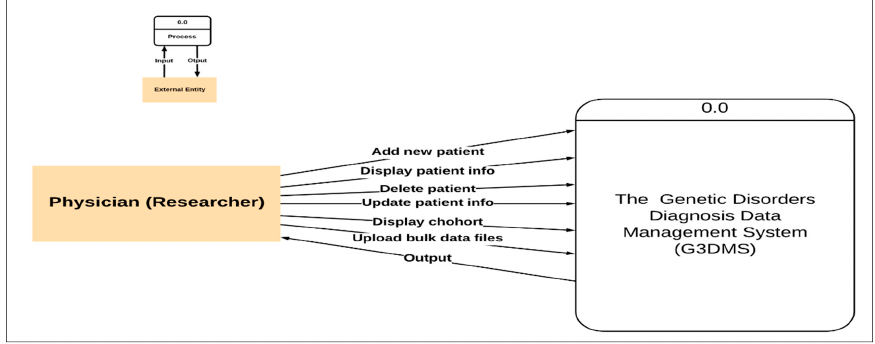
Figure 4. A context diagram (data flow diagram (DFD) level zero).